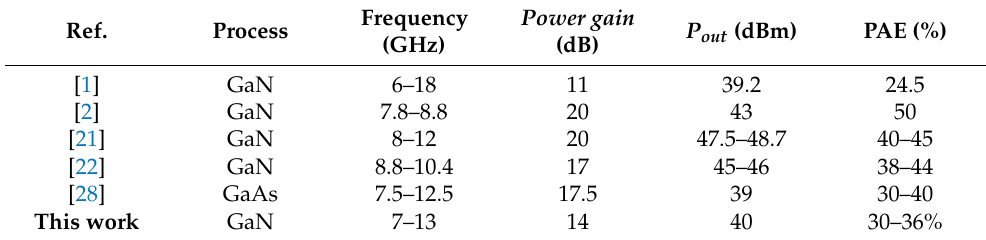
Table 3. Comparison to previously published MMIC